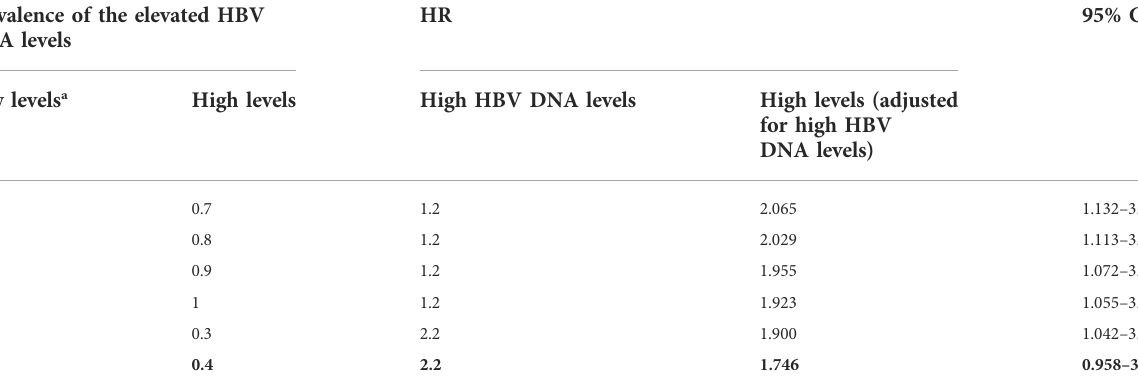
DNA levels eliminated any signi fi cant difference between the two groups. This sensitivity analysis indicates that our analysis results were robust.